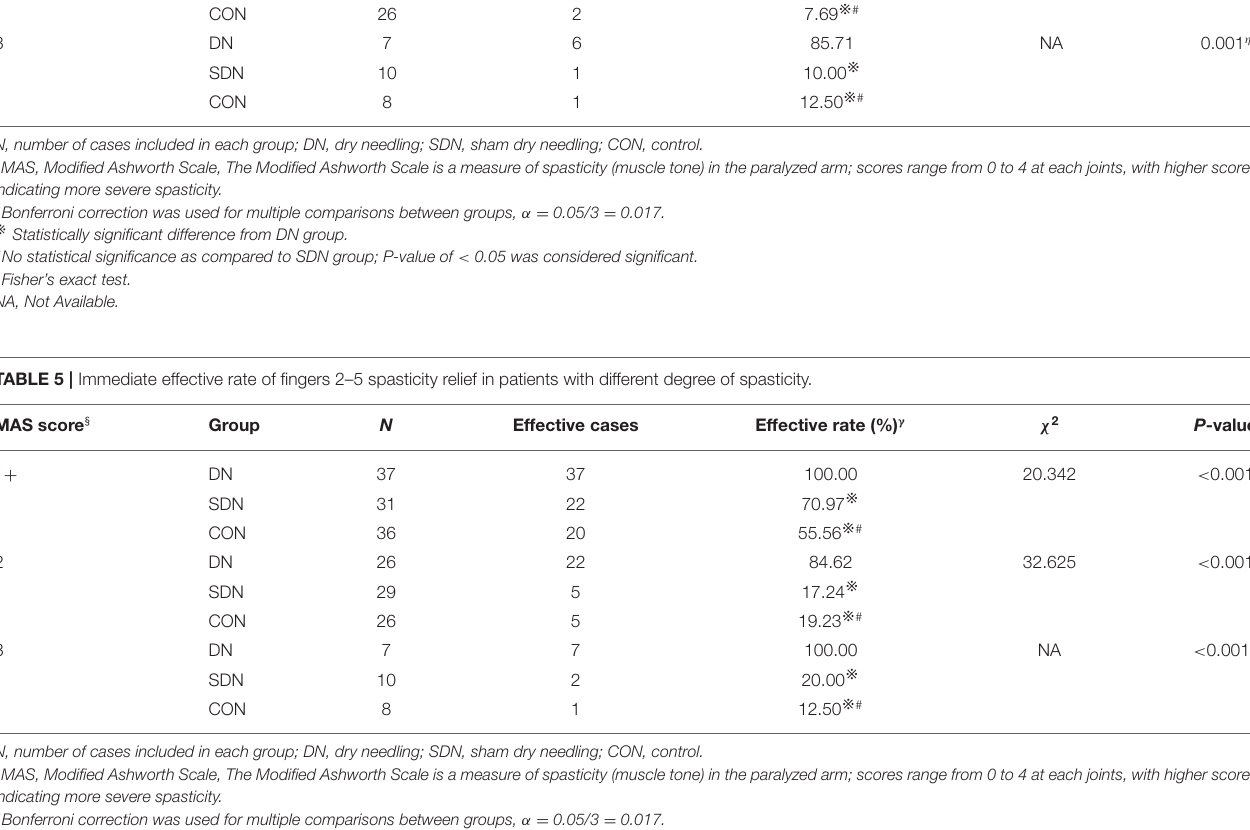
Wrist flexor spasticity